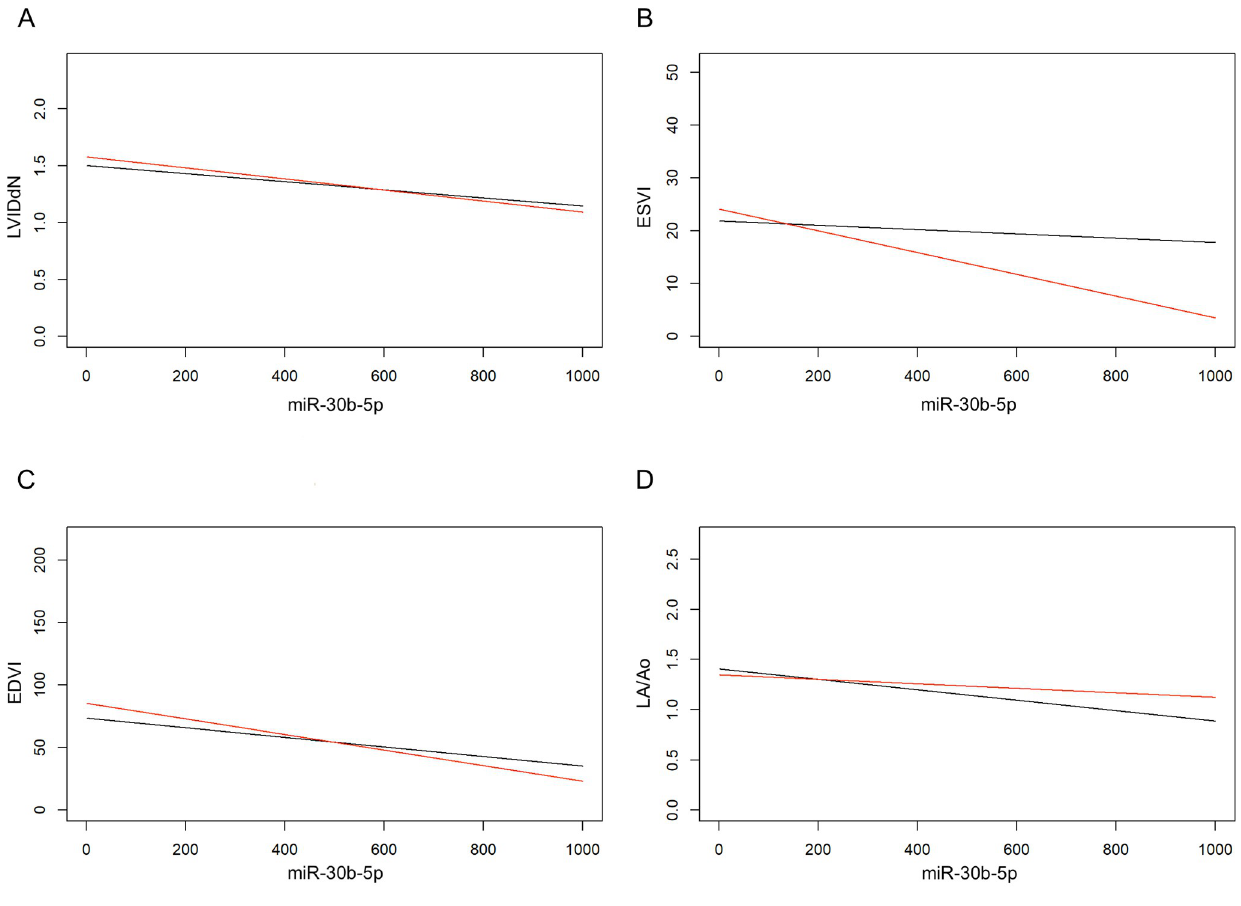
Fig 1. Marginal effect of plasma miR-30b-5p expression on echocardiographic variables at T0 and T1. Black line: T0. Red line: T1. A) Marginal effect of miR-30b-5p on LVIDdN. B) Marginal effect of miR-30b-5p on ESVI: The interaction between the two parameters is high since T0 and T1 lines are poorly parallel. C) Marginal effect of miR-30b-5p on EDVI. D) Marginal effect of miR-30b-5p on LA/Ao.